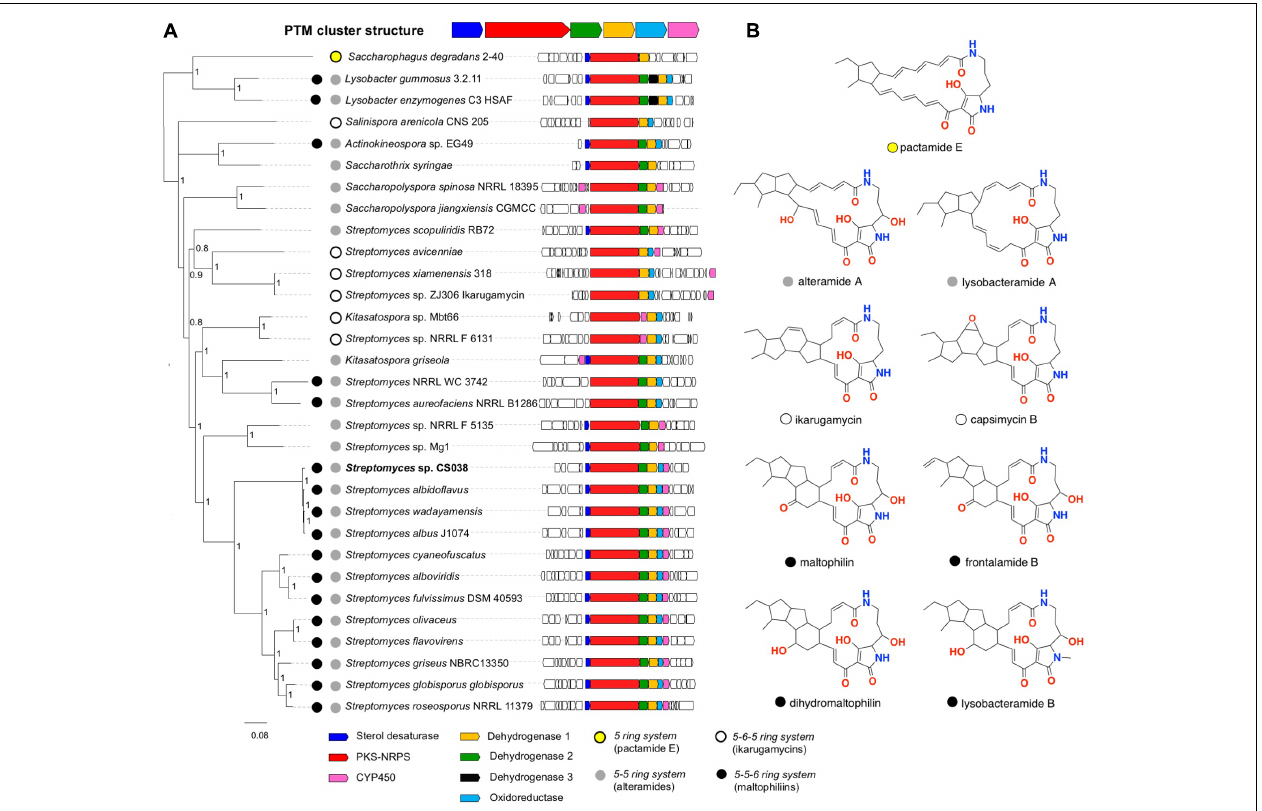
FIGURE 5 | Phylogenomic analysis of the PTM BGC. (A) The PTM BGCs from selected genomes are sorted after the NRPS-PKS phylogeny at the left. The posterior probability values are shown at the nodes of the tree. Streptomyces sp. CS038, a cone snail-associated isolate, is highlighted in bold letters. Its sequence represents the conserved PTM BGCs of all cone snail-associated streptomycetes reported in this work. Predicted ring composition is indicated for each BGC with colored circles. (B) Selected examples of PTMs based on their ring